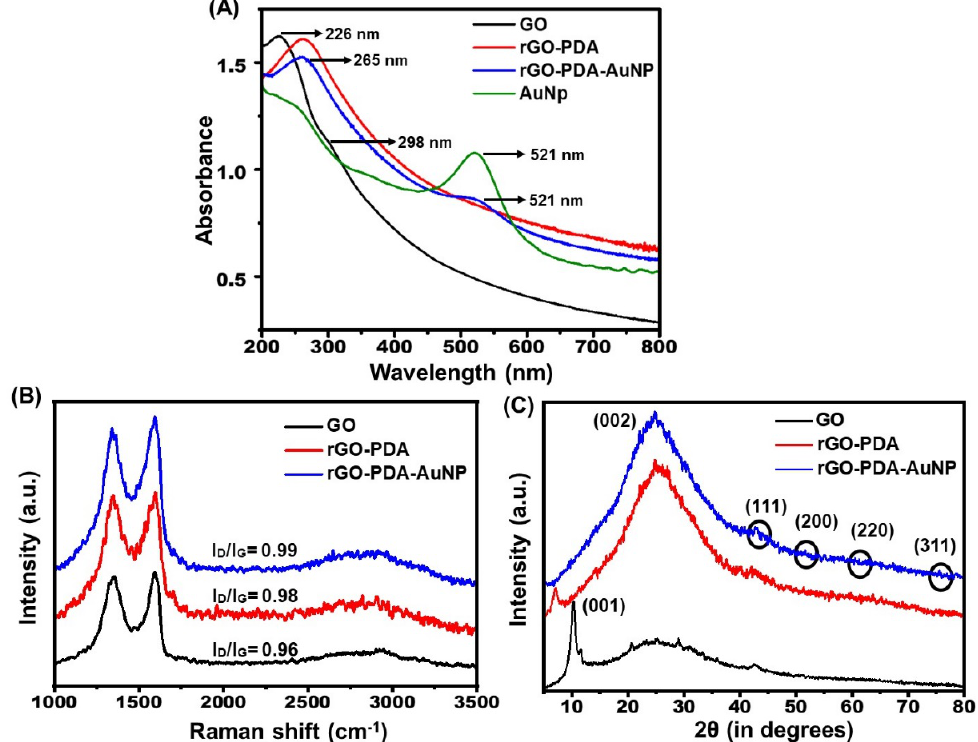
Figure 1. ( A ) UV-visible absorption spectra, ( B ) Raman spectra, and ( C ) X-ray diffraction patterns of Figure 2. This is a figure. Schemes follow the same formatting. If there are multiple panels, they GO, rGO-pDA, and rGO-pDA-AuNP should be listed as: ( a ) Description of what is contained in the first panel. ( b ) Description of what is contained in the second panel. Figures should be placed in the main text near to the first time they are cited. A caption on a single line should be centered.